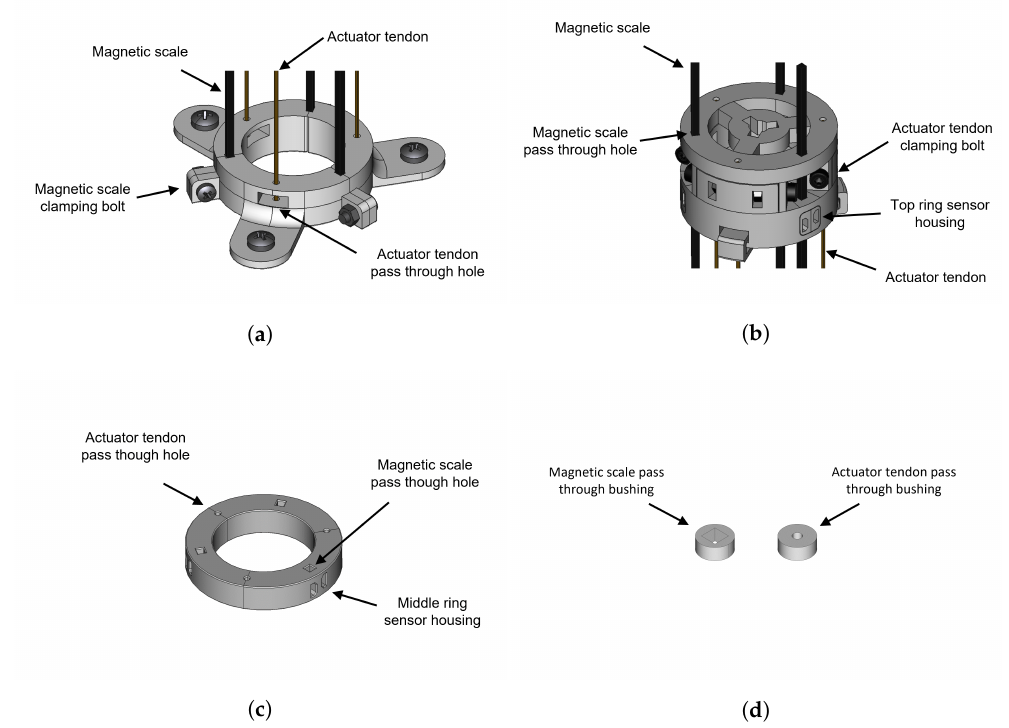
Figure 12. Rigid parts of the SCM robot module: ( a ) base ring, ( b ) distal ring, ( c ) middle ring, ( d ) pass-through bushing inserts (not to same scale).